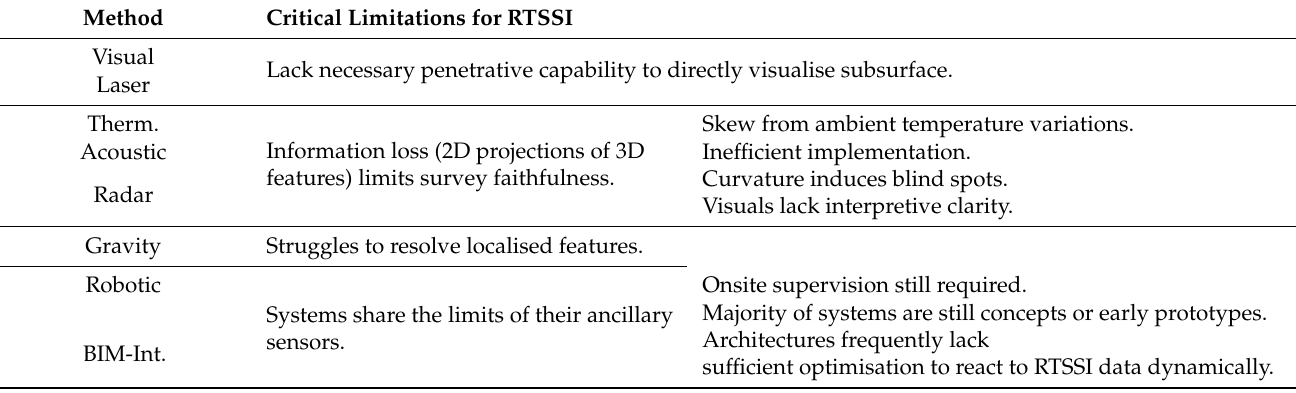
Table 1. Main current issues facing NDI